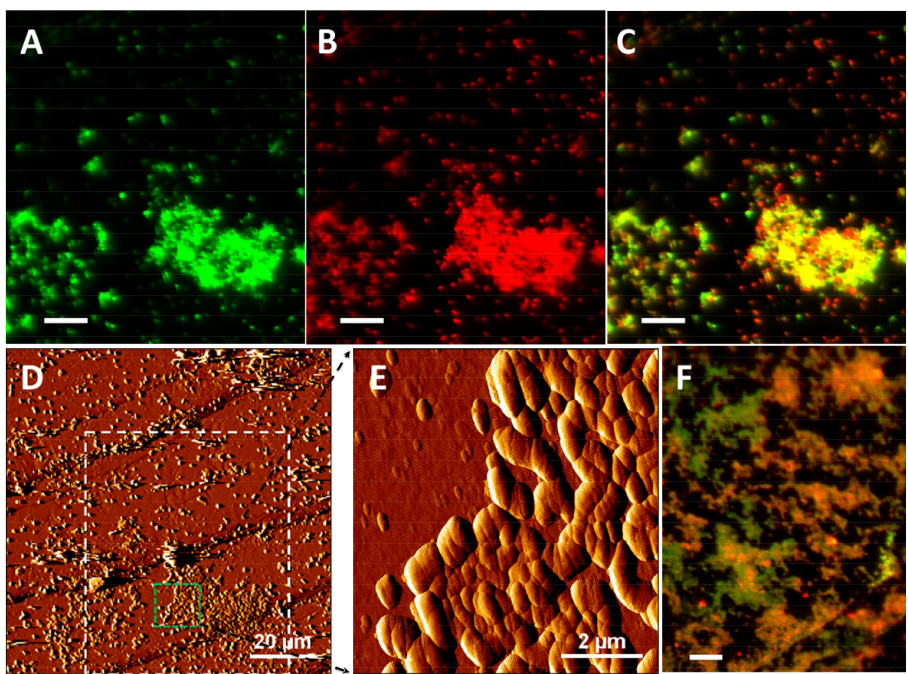
Figure 3. Surface colonization and partial biofilm formation by L. ferrooxidans ZC on a pyrite coupon after 3 days ( A – E ) and 7 days ( F ) of incubation at 30 ◦ C and shaking at 130 rpm in the dark. AFM images ( D , E ), EFM images ( A – C , F ). EFM images: ( A ) biofilm cells stained by Syto ® 9 (Green). ( B ) biofilm cells stained by TRITC-Con A (Red). ( C , F ) combination of Syto ® 9 and TRITC-Con A. The framed area in ( D ) corresponds to the same area in ( A – C ) observed by EFM. The framed area in ( D ) is zoomed in ( E ). Typical morphology of spiral is shown in ( E ). Bars in ( A – C , F ) represent 10 µ m.